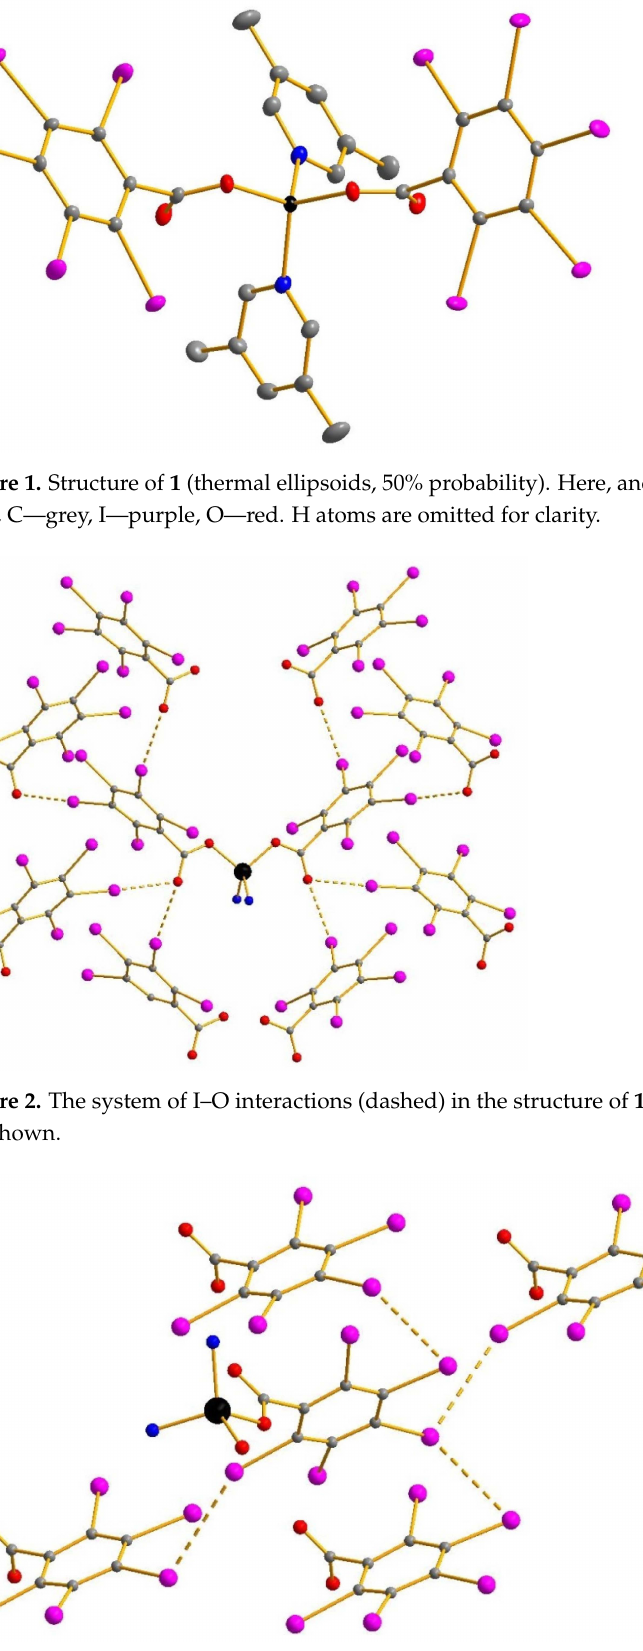
Figure 3. The system of I–I interactions (dashed) in the structure of 1 . Only N atoms of Py ligands are